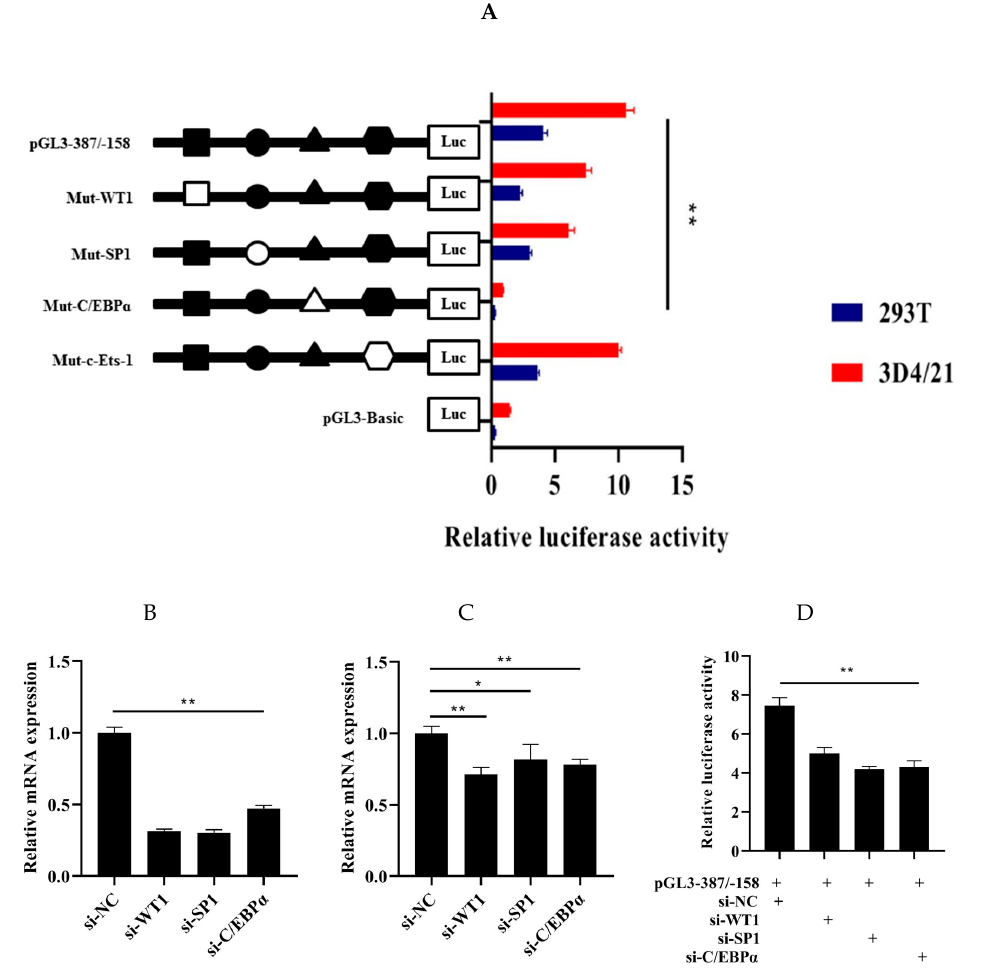
/ EBP α in the transcription regulation of HMOX1 gene. ( A ) Luciferase Figure 5 Figure 5. Role of WT1, Sp1, and C activity analysis with site-directed mutagenesis of WT1, Sp1, C / EBP α , and c-Ets-1 sites. Solid and hollow represent wild-type and mutant-type, respectively. ( B ) Interference e ffi ciency of WT1, Sp1, and C / EBP α . ( C ) The mRNA expression level of HMOX1 gene by inhibition with si-WT1, si-Sp1, and si-C / EBP α . ( D ) Luciferase activity after co- transfection of si-WT1, si-Sp1, and si-C / EBP α with pGL3-387 / − 158. (* indicates p < 0.05, ** indicates p <